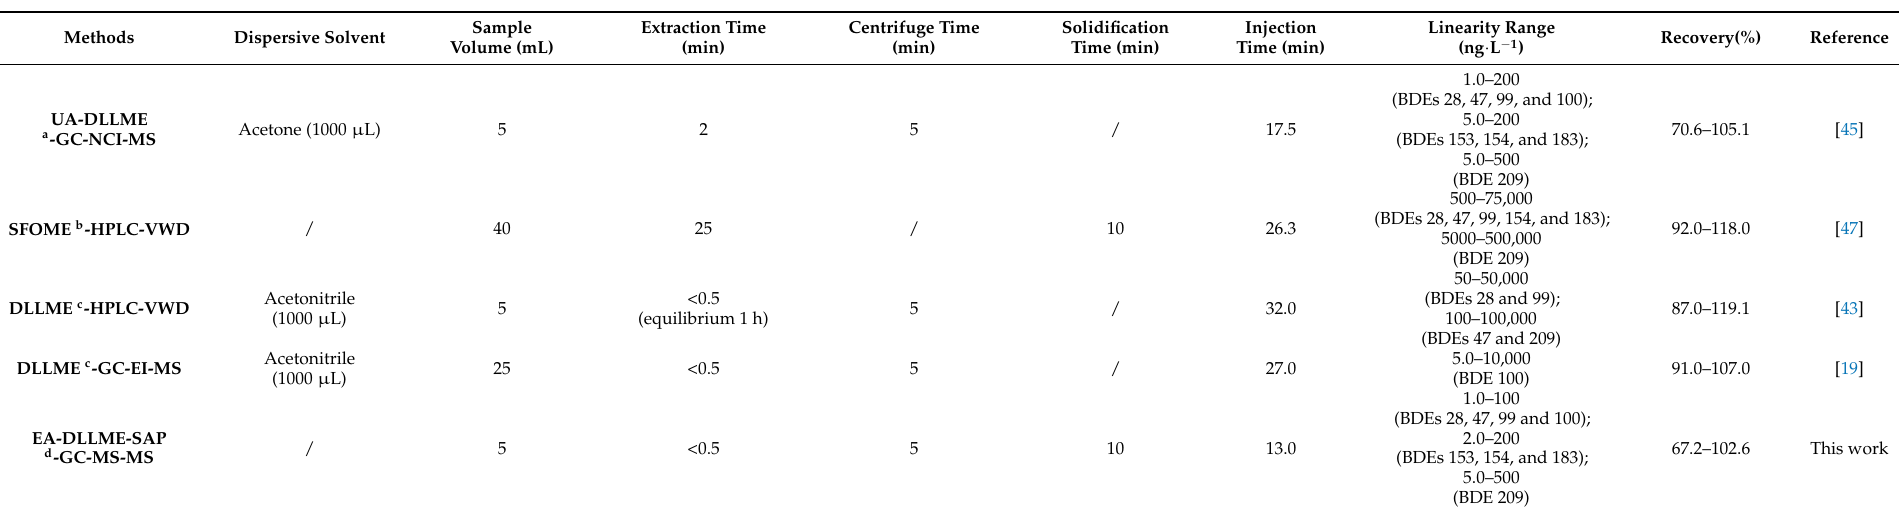
Table 3. Comparison of the EA-DLLME-SAP method with other reported approaches for